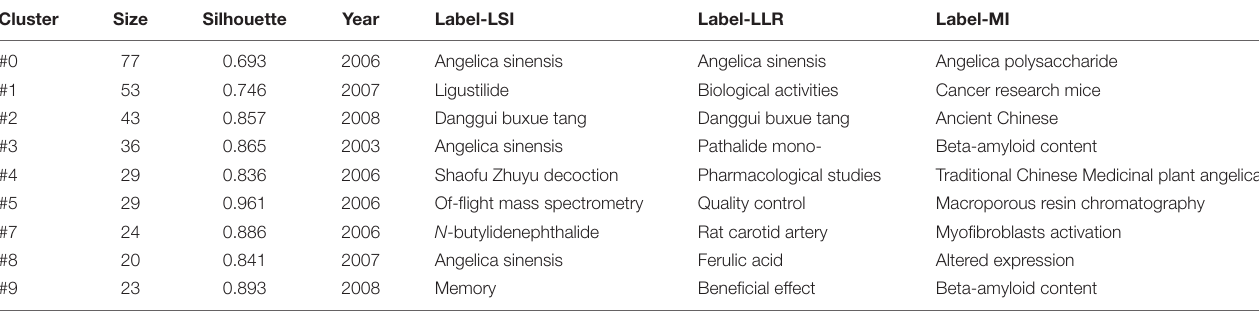
TABLE 4 | The largest nine clusters of document co-citation in Angelica sinensis research.